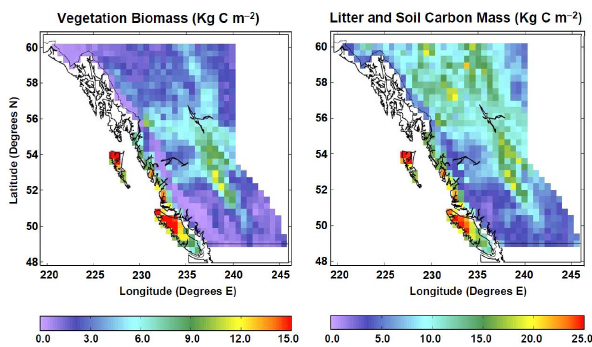
Fig. 4. Spatial distribution of simulated vegetation biomass (left panel) and litter and soil carbon mass (right panel) (Kg C m − 2 ) . Data are derived from the CLIM + CO 2 simulation and averaged over the period 1990–2005.